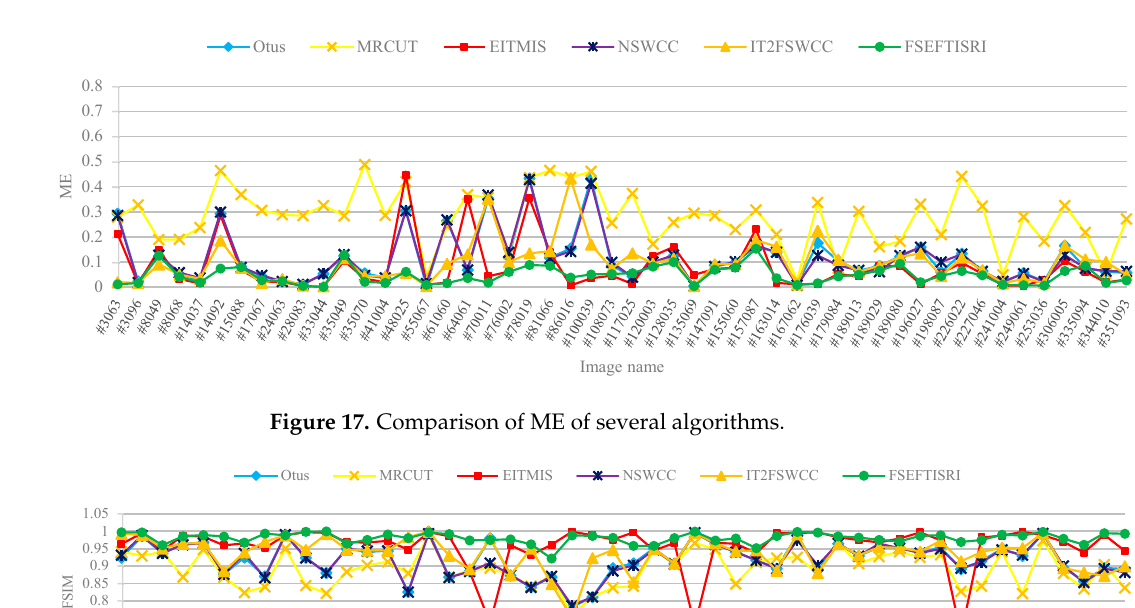
Table 4. Mean value and variance of evaluation indexes of several algorithms in BSDS.